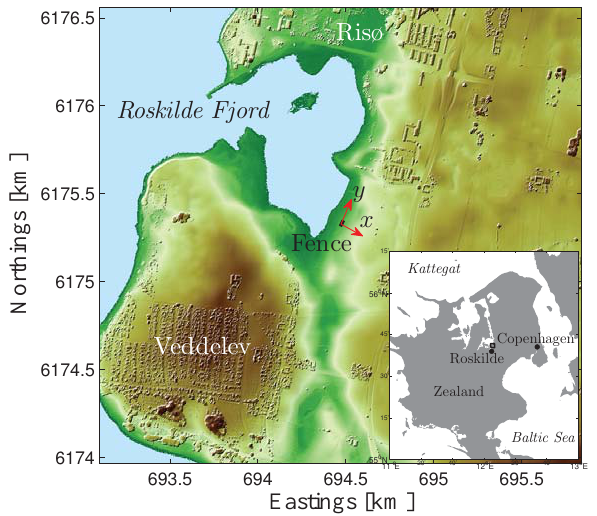
Figure 2. The fence experiment on a digital surface model (UTM32 WGS84) of the area surrounding Risø’s test station. Cropland and grassland are shown in green, cropland and artificial land in light brown, rural areas and buildings in brown, and the waters from the fjord in light blue. The reference coordinate system is shown in red. In the bottom-right part, the test site location (black rectangle) on the island of Zealand, Denmark, is illustrated.